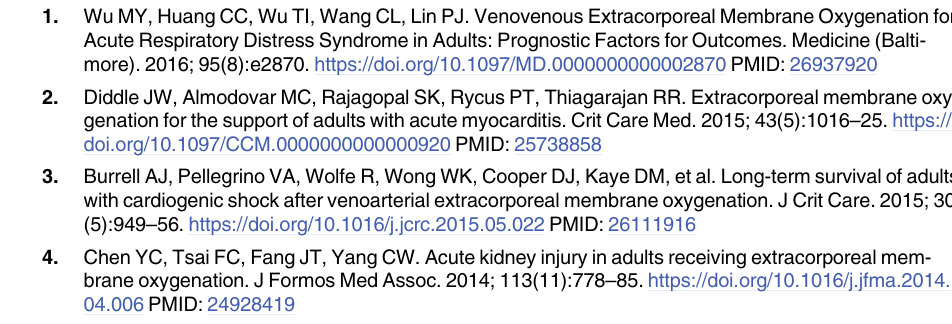
S4 Table. Risk factor analysis of D-AKI of patients with all indications of ECMO.